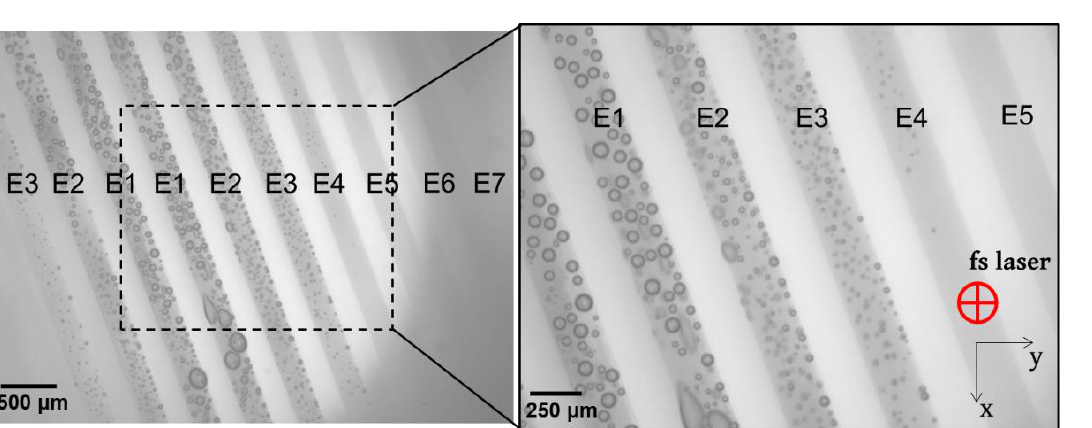
Figure 2. Top-view of one laser-treated ex vivo pig lens after exposition to different femtosecond laser energies. Images were acquired 5 min after irradiation, using an optical microscope at ×25 and ×45 magnifications. The laser settings are explained in Figure 1. Microscopic top-view provides information about the upper-most layer of laser-treated matrices. Cavitation and coalescence of bubbles are perfectly visible from high laser-pulse energy settings.